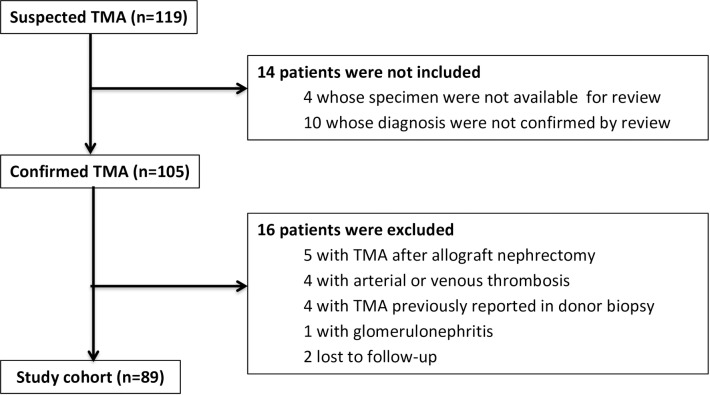
Casuistic selection flowchart.Allograft biopsies of kidney or pancreas-kidney transplanted patients with suspected TMA were reviewed by the same pathologist. Confirmed TMA was defined as the presence of occlusive fibrin-platelet thrombi in at least one glomerulus and/or arteriole. TMA = Thrombotic microangiopathy.